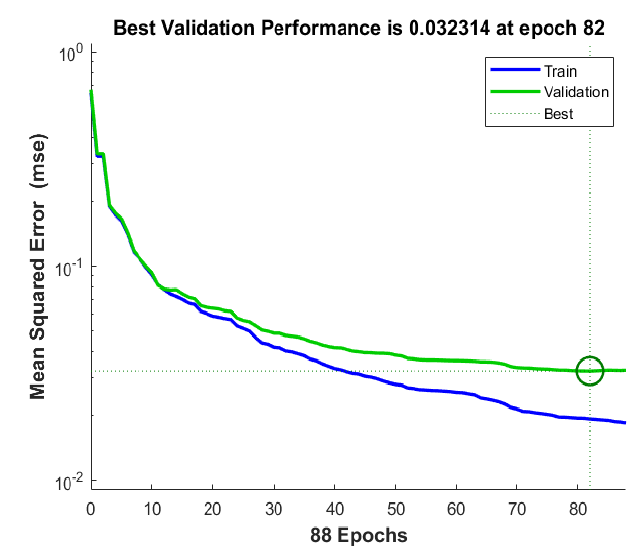
Figure 6. The optimization process of the feedforward network.